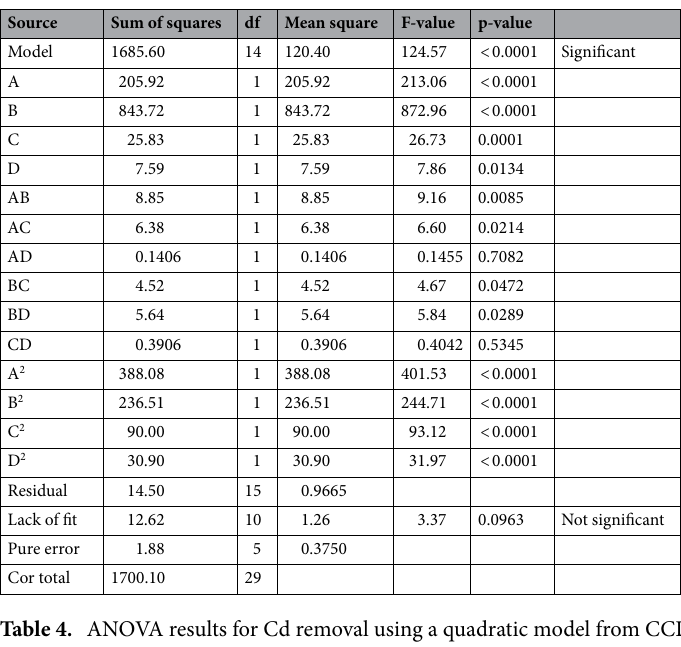
Table 4. ANOVA results for Cd removal using a quadratic model from CCD.